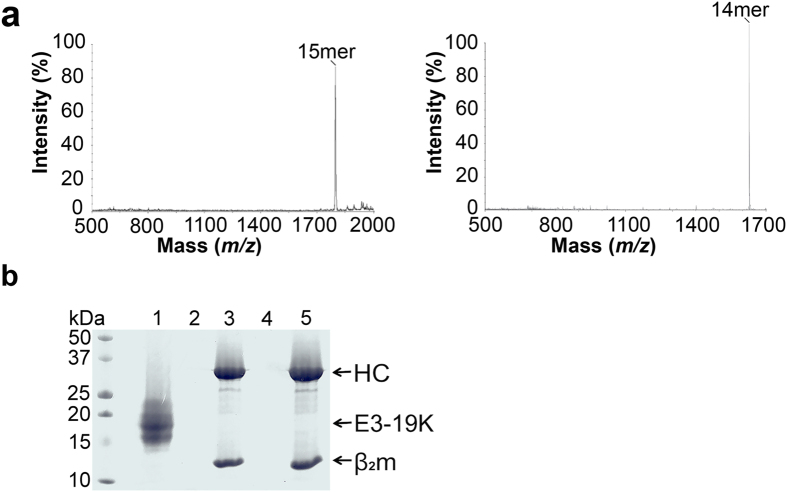
Characterization of HLA-B*0801/precursor complexes.(a) MALDI-TOF MS analysis of HLA-B*0801/(RA)3ALRSRYWAI and HLA-B*0801/(RA)3AAKKKYKL complexes shows peaks corresponding to (RA)3ALRSRYWAI 15mer (m/z = 1817) and (RA)3AAKKKYKL 14mer (m/z = 1631) ligands. (b) Ni-NTA agarose beads were used in the capture of Ad4 E3-19K(His)6 (lane 1), HLA-B*0801/ALRSRYWAI (lane 2), HLA-B*0801/(His)6ALRSRYWAI (lane 3), HLA-B*0801/AAKKKYKL (lane 4), and HLA-B*0801/(His)6AAKKKYKL (lane 5). The supernatants of the pelleted, washed, and boiled beads were loaded on SDS-PAGE gel (15%).